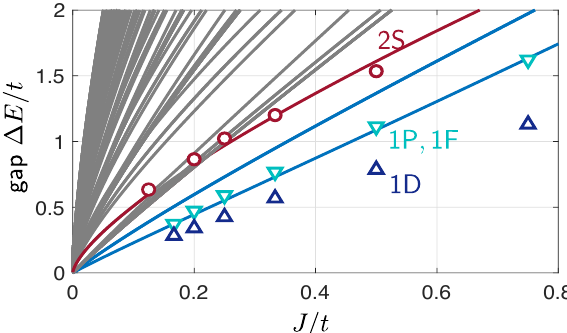
Figure 15: Meson Regge trajectories from the spinon-chargon model introduced here. We calculate the excitation energy gaps ∆ E from the ground state from the spinon- chargon model at the nodal point, k = ( π/ 2, π/ 2 ) , solid lines. These predictions are compared to our numerical DMRG results (data points), see Ref. [ 30 ] . The lowest excitations can be identified as rotational (blue) and vibrational (red) by the depen- dence of their energy gap on J / t . Higher excited states (gray) show similar, though less pronounced